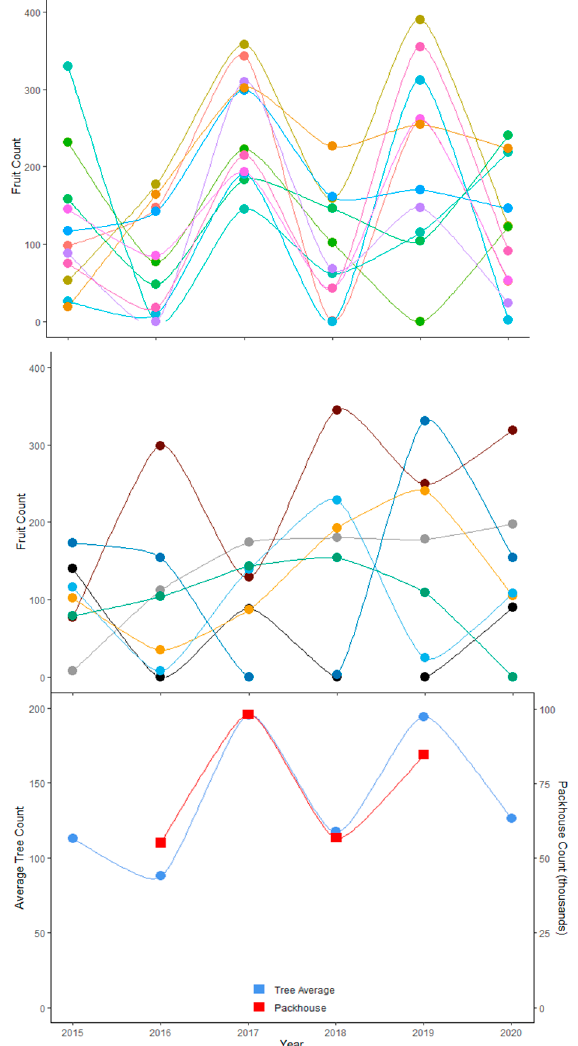
Figure 8. Fruit load per tree of 18 mango trees from one orchard, over 6 years. Top panel : trees demonstrating synchronicity in biennial bearing, with ‘on’ years in odd years; middle panel : trees demonstrating biennial bearing with ‘on’ years in even years or a non-biennial bearing pattern; Colored lines represent individual trees in top and middle panel; bottom panel : average fruit load of 18 trees and the packhouse count for the orchard (494